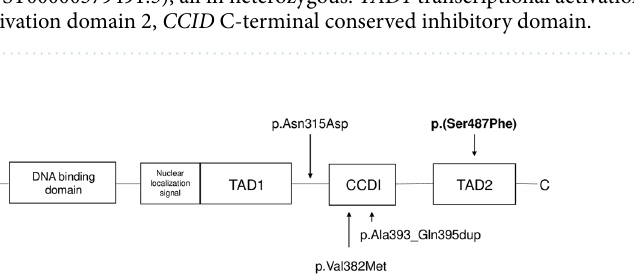
Figure 2. Schematic representation of the GCM2 gene, representing the position of 3 missense variants and one short duplication. Variant marked in bold has not been reported to date. TAD1 transcriptional activation domain 1, TAD2 transcriptional activation domain 2, CCID C-terminal conserved inhibitory domain.